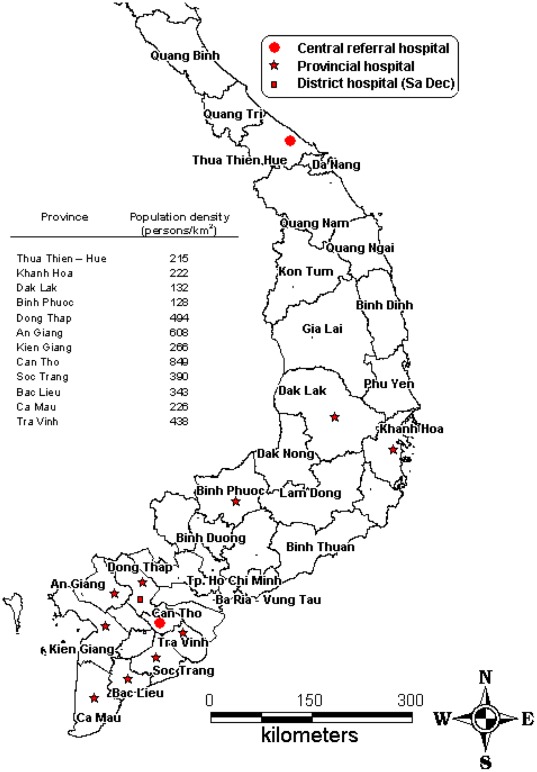
Locations of study sites.Map of southern Vietnam indicating participating hospitals and population density in the catchment area of each site.